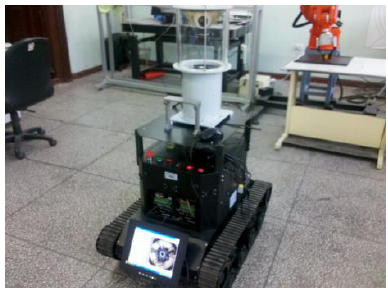
Figure 3. The mobile robotic